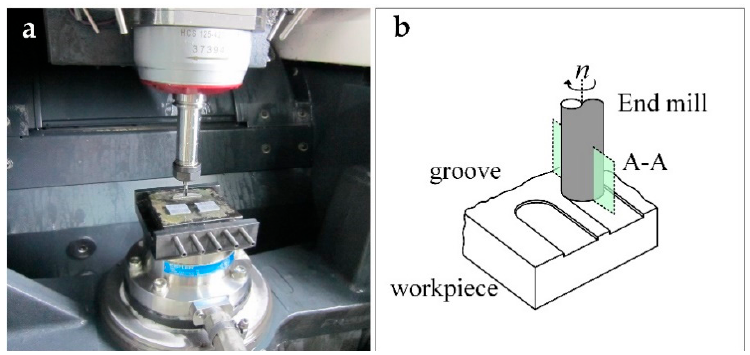
Figure 7. ( a ) Experimental setups and ( b ) a sketch of groove milling. Table 3. Experimental parameters of the two cases.